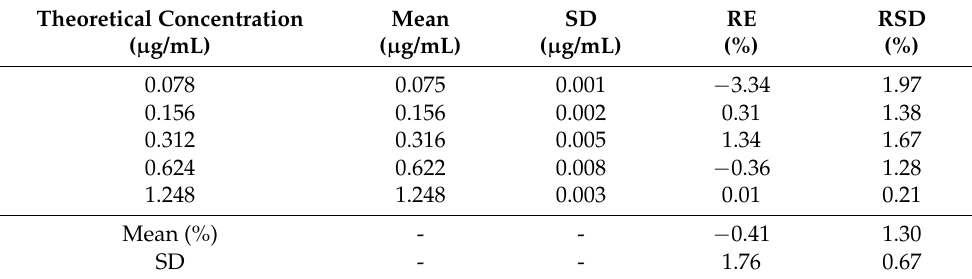
Table 8. Accuracy and intermediate precision of the fluorometric